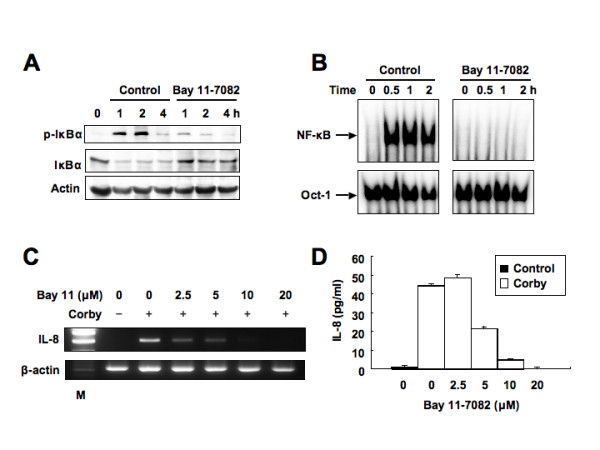
Bay 11-7082 blocks L. pneumophila-induced NF-κB activation and IL-8 secretion. Jurkat cells were pretreated with or without Bay 11-7082 (20 μM) for 1 h prior to L. pneumophila Corby infection and subsequently were infected with Corby (MOI, 100:1) for the indicated times. Cell lysates were prepared and subjected to immunoblotting with the indicated antibodies (A) and nuclear extracts from the harvested cells were analyzed for NF-κB and Oct-1 (B). Jurkat cells were pretreated with the indicated concentrations of Bay 11-7082 for 1 h prior to Corby infection and subsequently infected with Corby (MOI, 100:1) for 4 h (C) and 24 h (D). IL-8 mRNA expression on the harvested cells was analyzed by RT-PCR (C) and the supernatants were subjected to ELISA to determine IL-8 secretion (D). Data in (A)-(C) are representative examples of three independent experiments with similar results. Data are mean ± SD from three experiments.